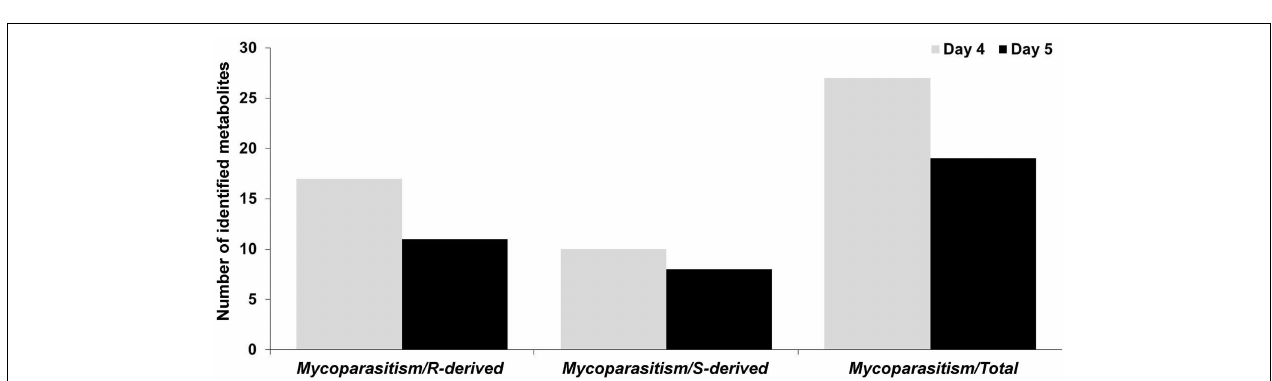
FIGURE 2 | Cumulative mass spectra of R. solani - S. elegans dual-cultures 4 (D4) and 5 (D5) days following treatments. Data were aquired in positive (ESI + ) and negative (ESI − ) electrospray